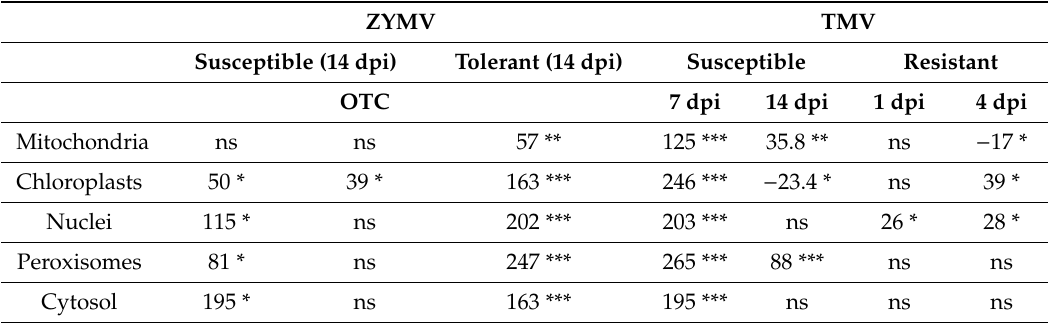
Table 3. Changes in percentage of subcellular glutathione contents during Zucchini Yellow Mosaic Virus (ZYMV) and Tobacco Mosaic Virus (TMV) infection. Glutathione contents were determined at di ff erent days post inoculation (dpi) in OTC-treated, susceptible, and tolerant ZYMV-infected pumpkin and susceptible and resistant TMV-infected tobacco plants and compared to the control [55,58,59]. Significant di ff erences were calculated using the Mann-Whitney U-test; *, ** and ***, respectively, indicate significance at the 0.05, 0.01 and 0.001 levels of confidence; ns = not significantly di ff erent. OTC = L-2-oxothiazolidine-4-carboxylic acid. ZYMV